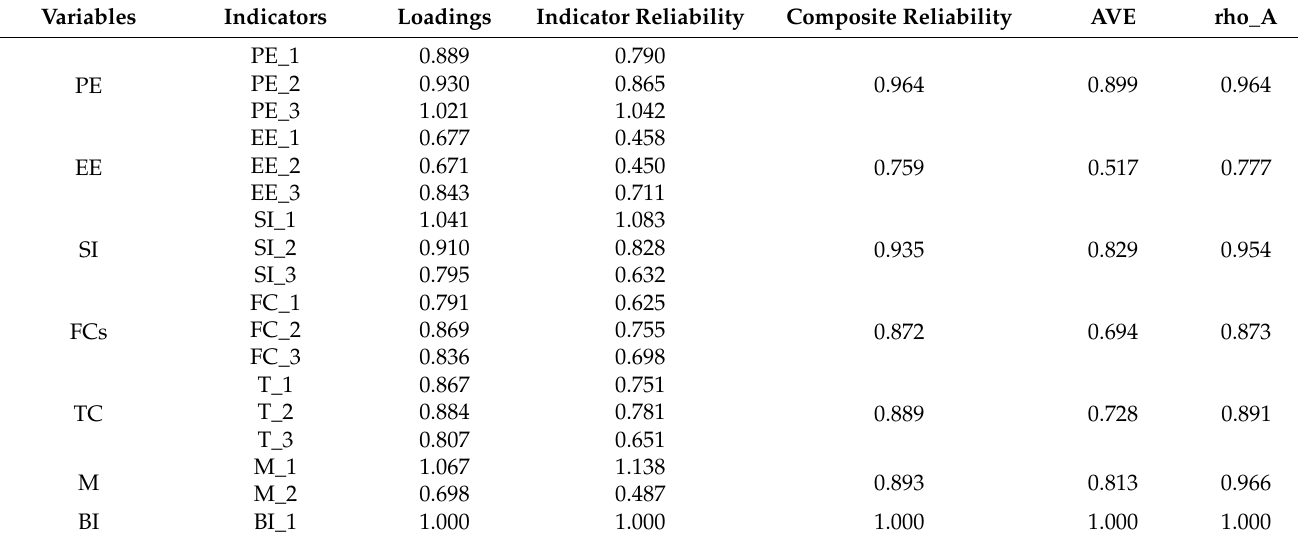
Table 1. Indicator and composite reliability: AVE